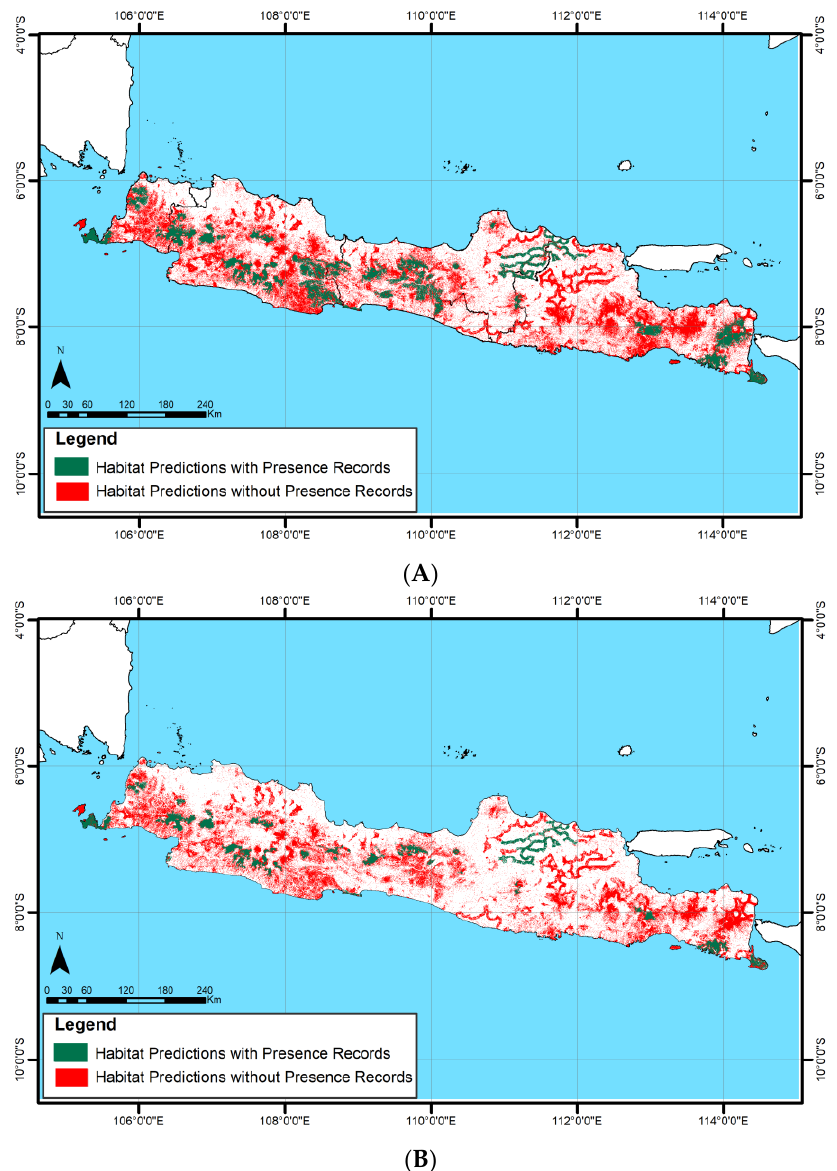
Figure 10. Javan leopard habitat suitability based on attendance records in ( A ) 2000 and ( B ) 2020.